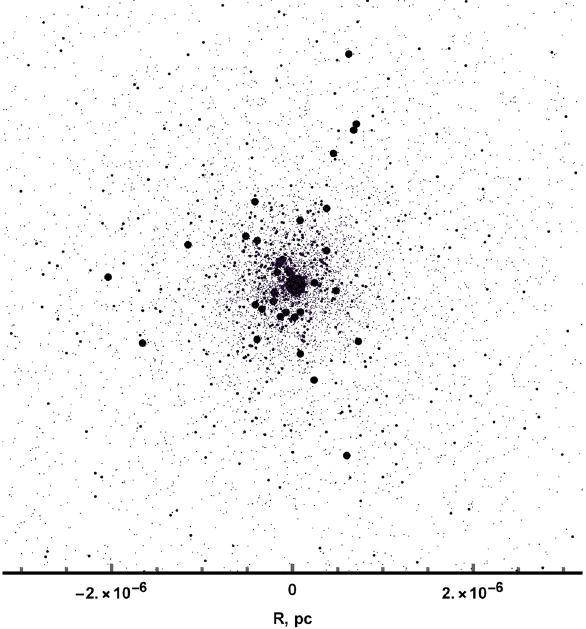
Fig. 6 The typical spatial black holes distribution within cluster, the result of numerical simulations. Black holes «sizes» show its mass dis- tribution but do not correspond to real